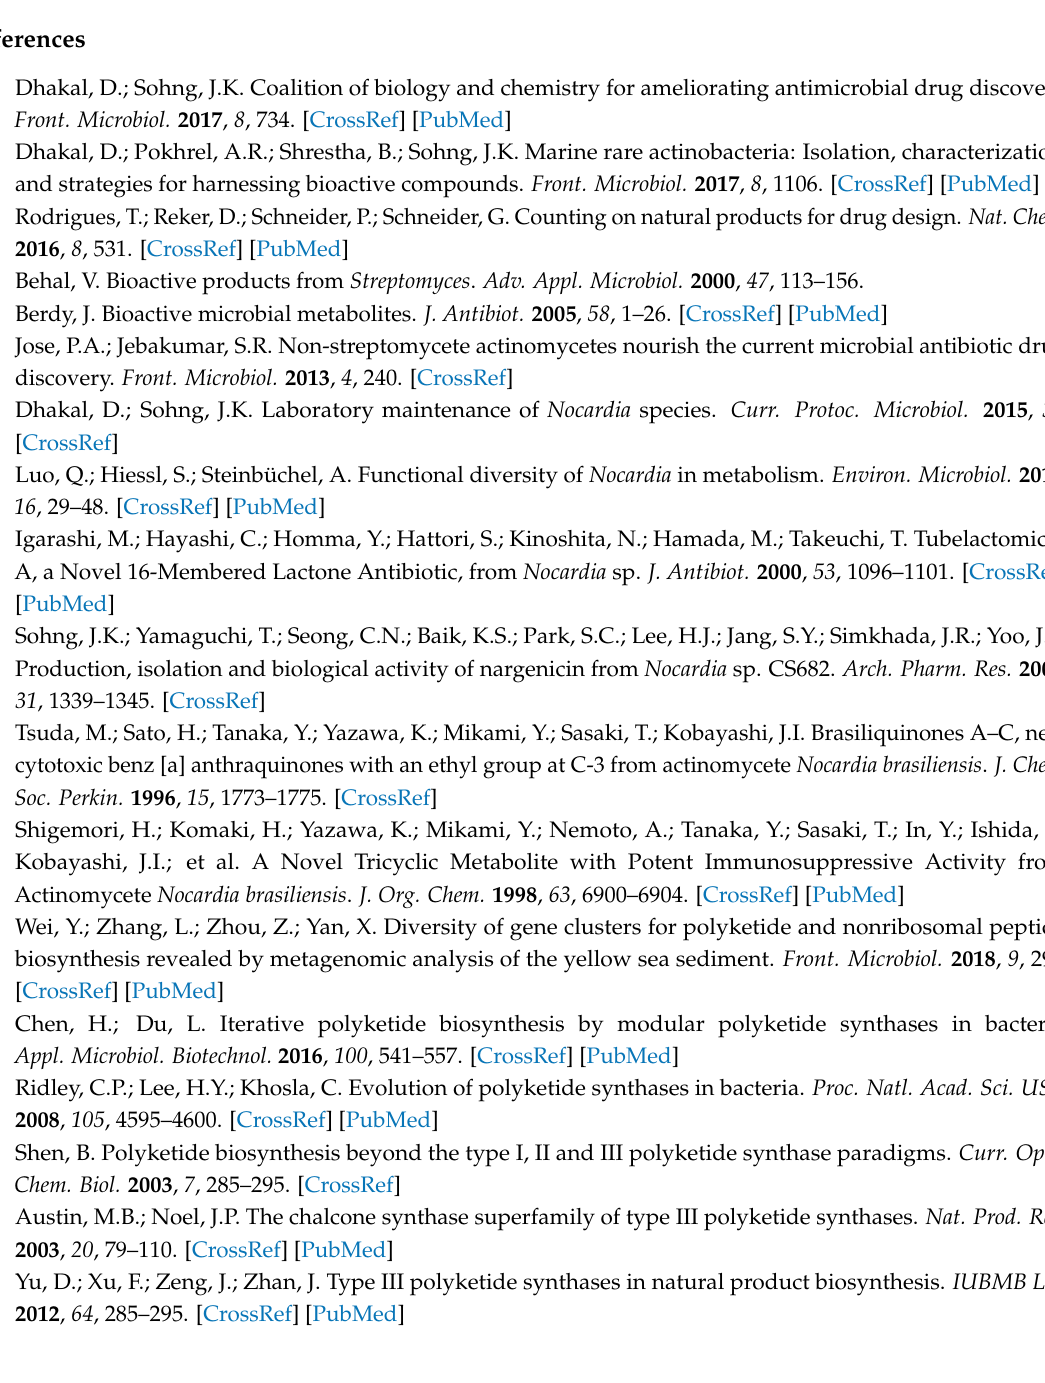
of compound IBR-3 against various cancer cell lines, Figure S14: Melanin formation assay of compound IBR-3 using B16F10 melanoma cell, Table S1: List of strains and vectors used in the study, Table S2: Oligonucleotides used in the